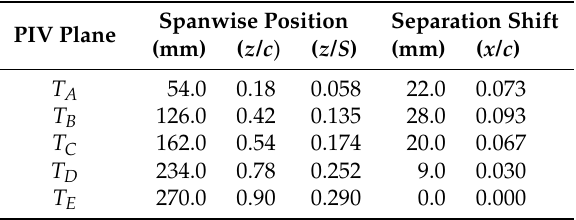
Table 1. Off-to-on chordwise shift of separation vs. spanwise position z : The origin is at the intersection of leading edge and tunnel